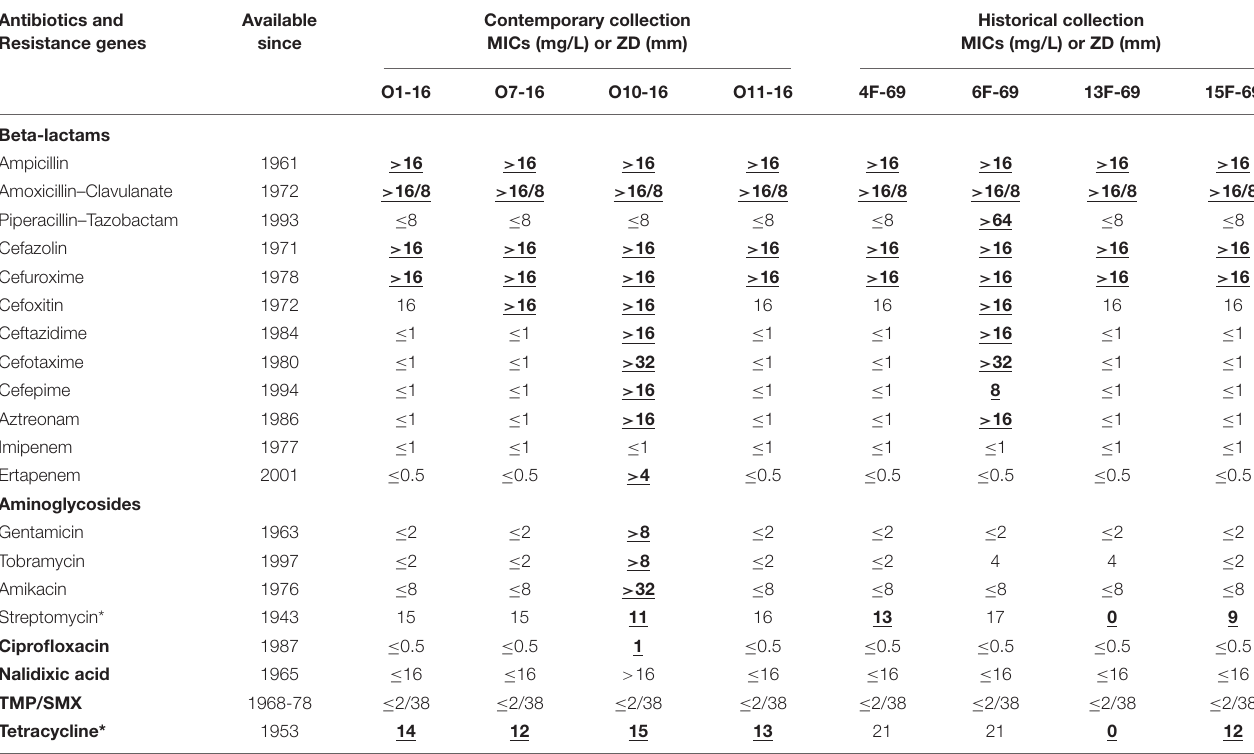
MIC values or zone diameters over the clinical cutoff (based on EUCAST 2019 criteria) are highlighted in bold, underlined numbers. NA, not available; TMP/SMX, trimethoprim/sulfamethoxazole. Asterisk, antibiotics tested only by disk diffusion test (25 µ g for streptomycin and 30 µ g for tetracycline).